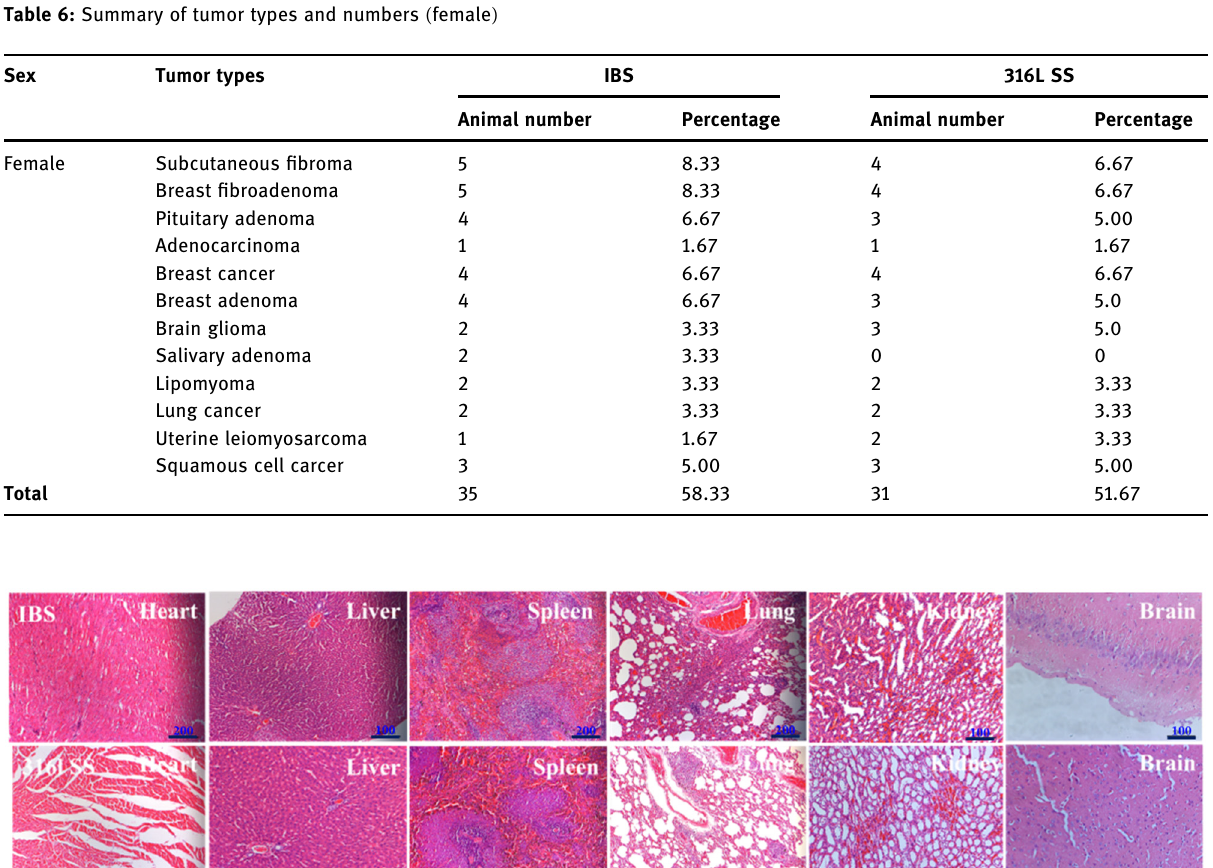
Table 6: Summary of tumor types and numbers ( female )